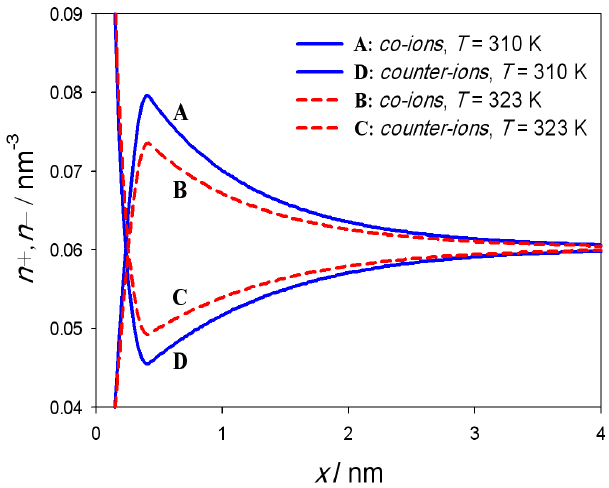
Figure 3. The calculated charge density profile of co-ions ( n − ) (A,B) and counter-ions ( n ) (C,D) of the electrolyte solution for two temperatures 310 K (full blue line) and 323 K + = 0 . 48 nm 2 below (dashed red line) and corresponding DPPC values of the area per lipid ( a 0 314 K and a = 0 . 60 nm 2 above 314 K ). The dipole moment of water was p = 3 . 1 Debye , 0 0 D = 0 . 42 nm , bulk concentration of salt n /N = 0 . 1 mol / l and concentration of water 0 A n /N = 55 mol / l , where N is Avogadro 0 w A A